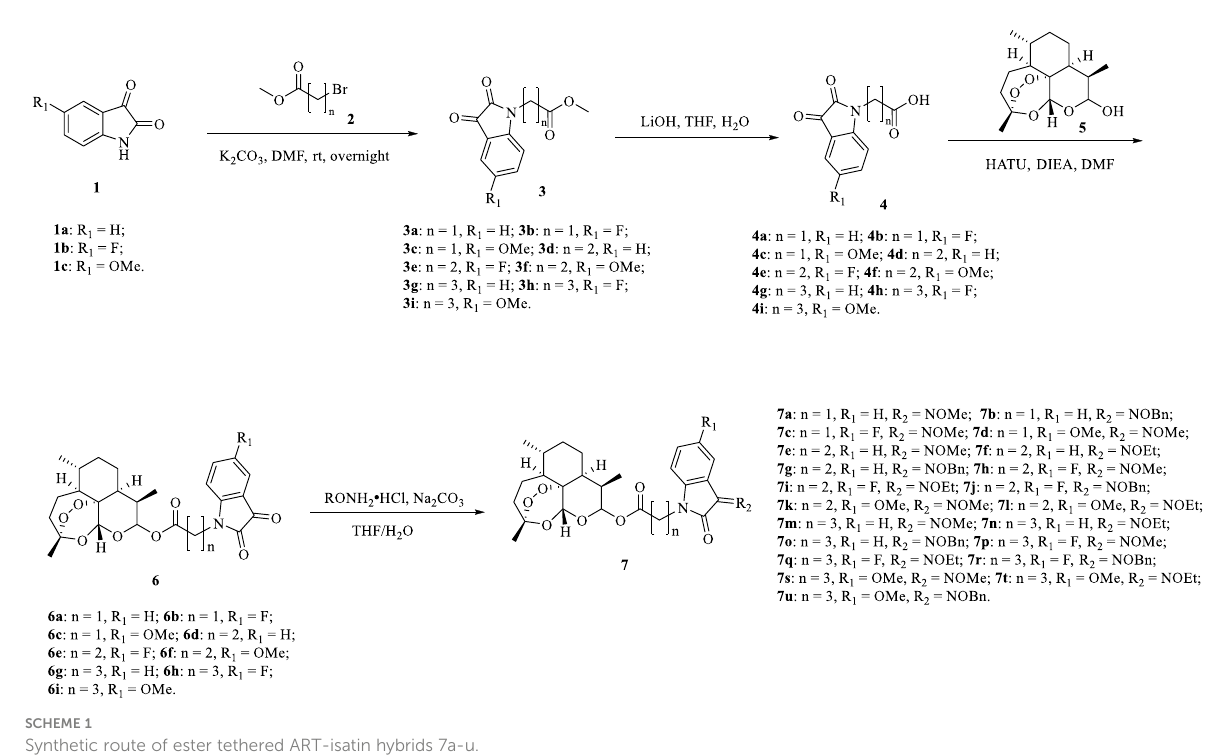
SCHEME 1 Synthetic route of ester tethered ART-isatin hybrids